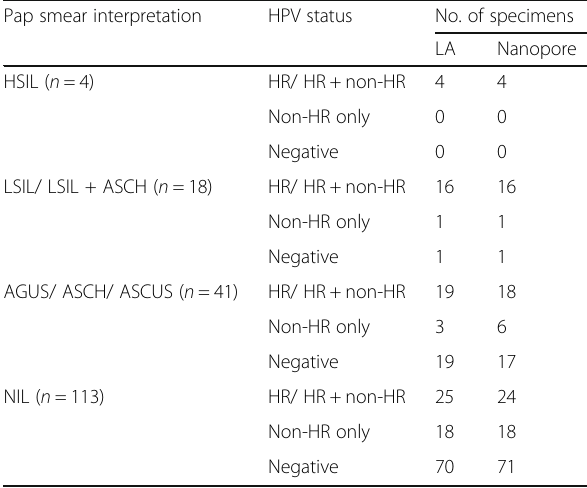
Table 8 Results of Pap smear, LA and Nanopore workflow. The calculations were based 176 quality control-valid specimens with Pap smear results